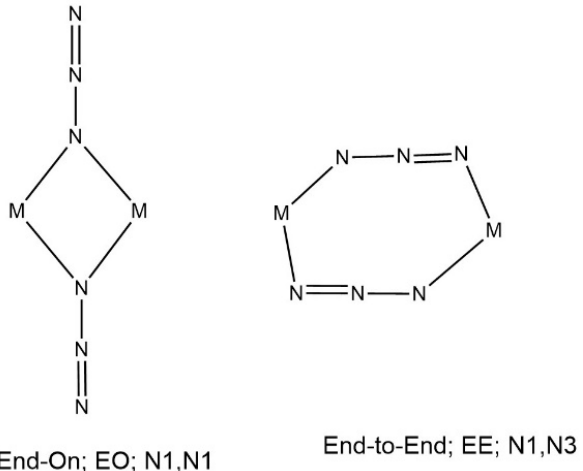
Figure 1. Schematic representation of the binding modes for bridging azido ligands between two metal ions M.